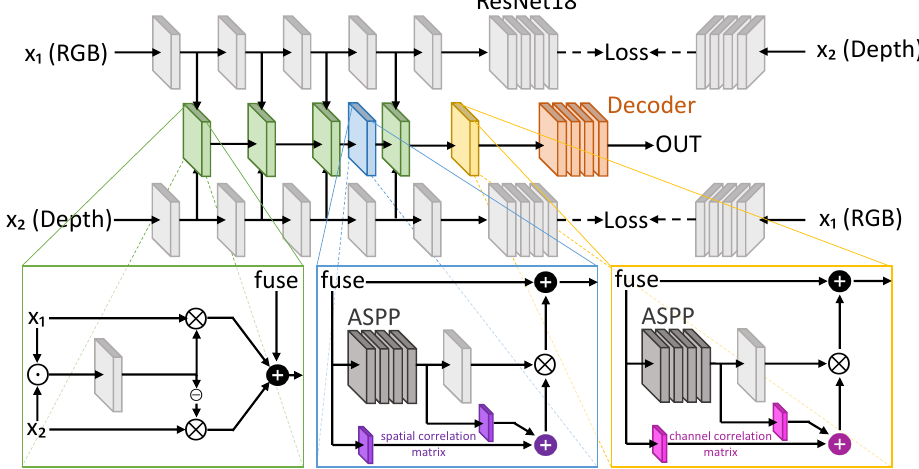
Figure 16. Architecture of the approach of Zhang et al. [115].